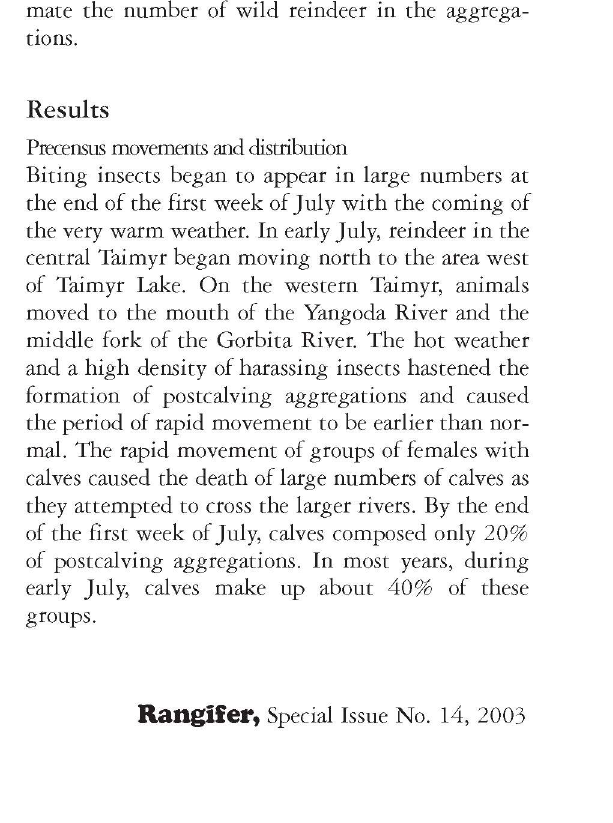
Fig. 1. Locations of concentrations of wild reindeer on the Taimyr Peninsula during 22-25 July 2000 (1 = Verhnetaimyr- skaya, 2 = Deptumalskaya, 3 = Yeniseyskaya, 4 = Tareyskaya, • = other, smaller